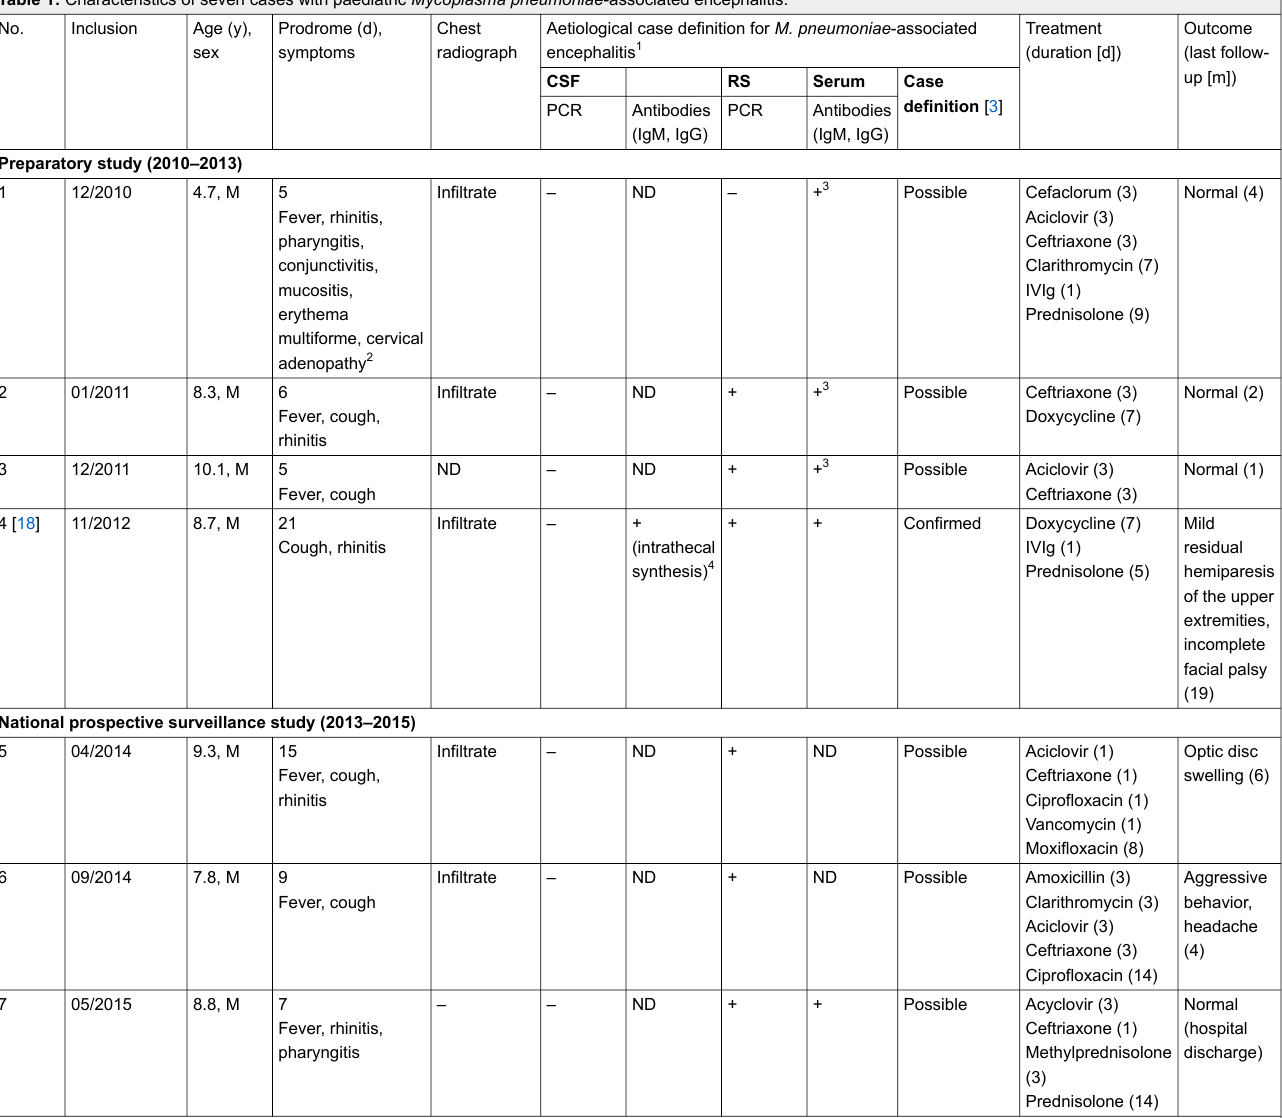
Table 1: Characteristics of seven cases with paediatric Mycoplasma pneumoniae -associated encephalitis.